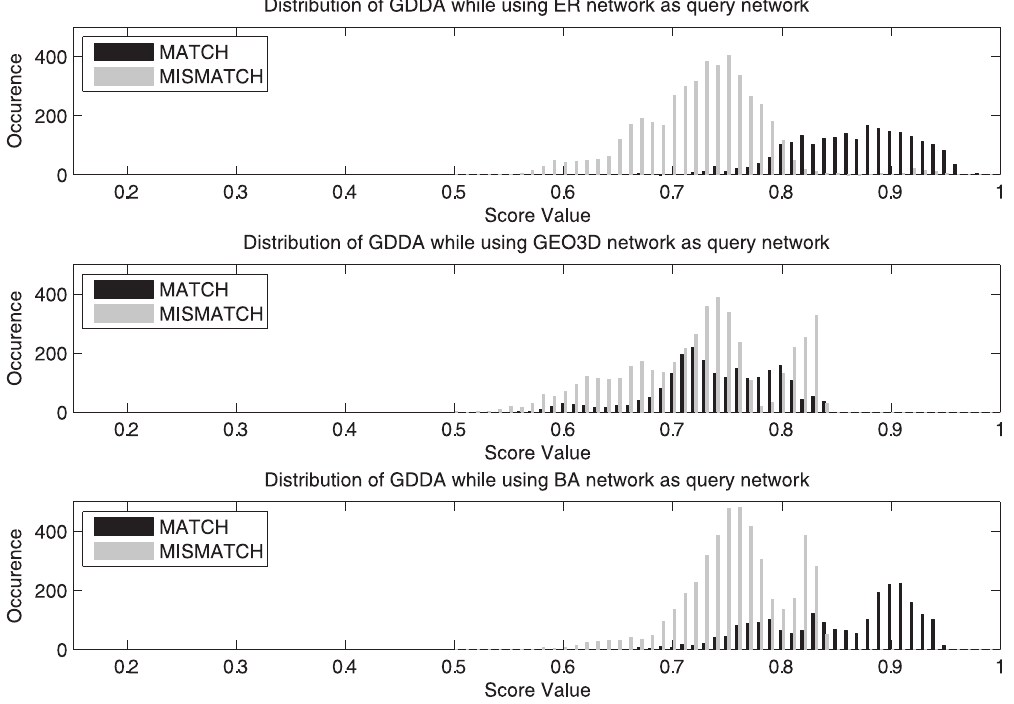
Figure 5. Sampled population of GDDA score. From top to bottom are a) ER network, b) GEO3D network, c) BA network as the query network used respectively.